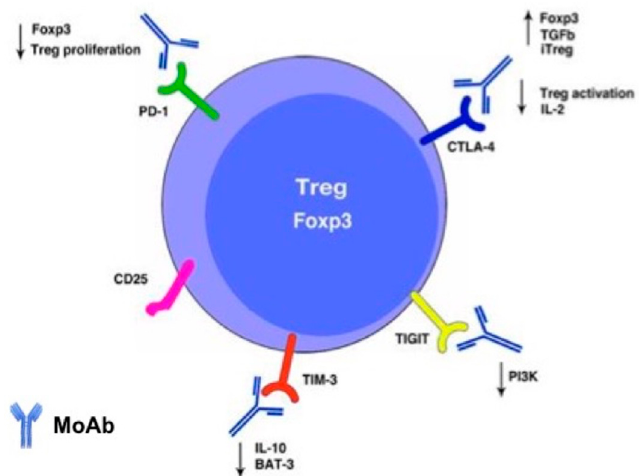
Figure 2. Functional effects upon the binding of monoclonal antibodies (MoAb) to molecules expressed on surface of Tregs cells. The binding of MoAbs with CTLA-4, PD1, TIGIT or TIM 3 induce changes in Treg functions, affecting the overall immune responses against tumors. Table 2. FDA-approved immune checkpoint inhibitors (ICIs) for the treatment of stage III/IV NSCLC.